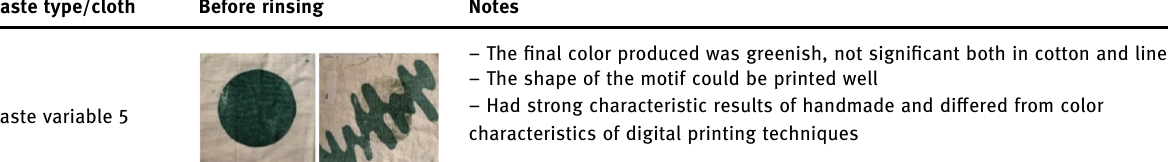
Table 6: Experiments on Spirulina platensis paste application on fabric Paste